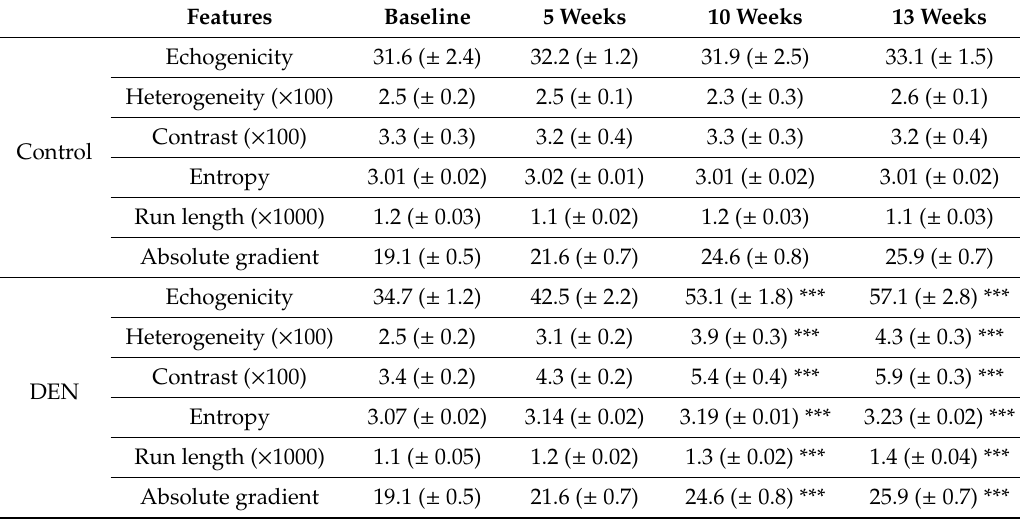
Table 2. Values of various texture features obtained prior to the start of DEN consumption (baseline) and 5, 10, and 13 weeks after DEN administration. Control rats did not receive